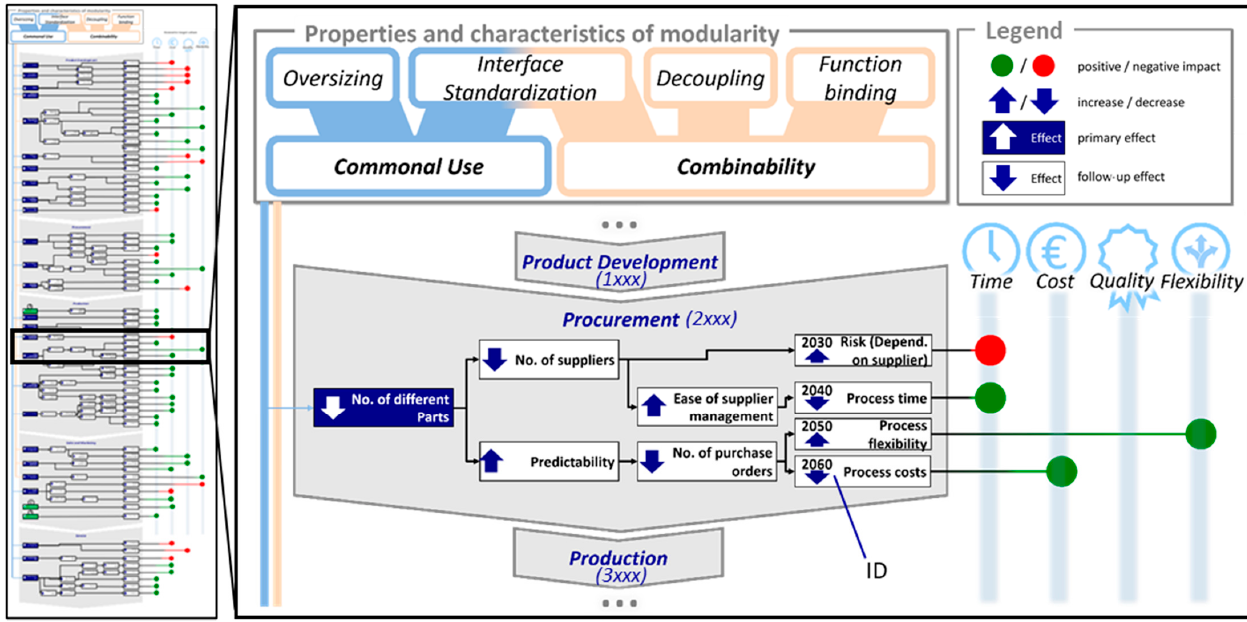
Figure 1. Visual-based static Impact Model of Modular Product Families (IMF) [10].